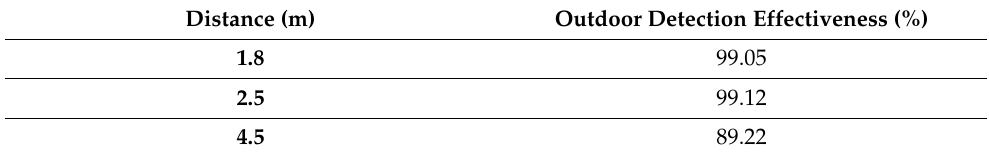
Table 2. Outdoor detection